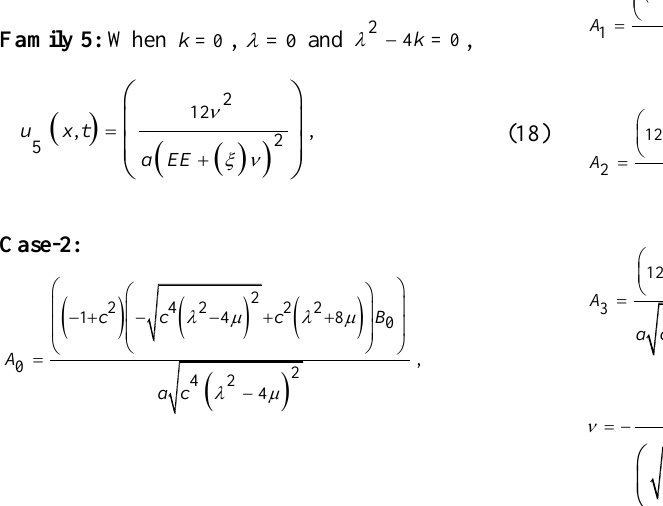
Figure-4. The 3D, density graphic and 2D surfaces of Eq. (18) in 0, 0, 4 c  = = = 0.5, 1, 0.75 a EE = = = and 1 t = .  